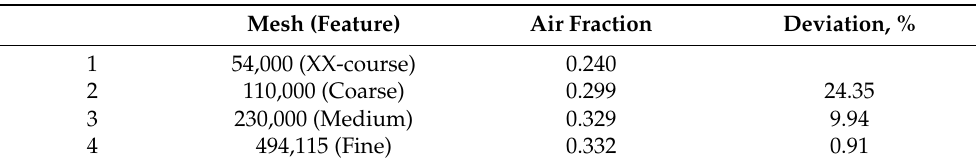
Table 1. Mesh dependency